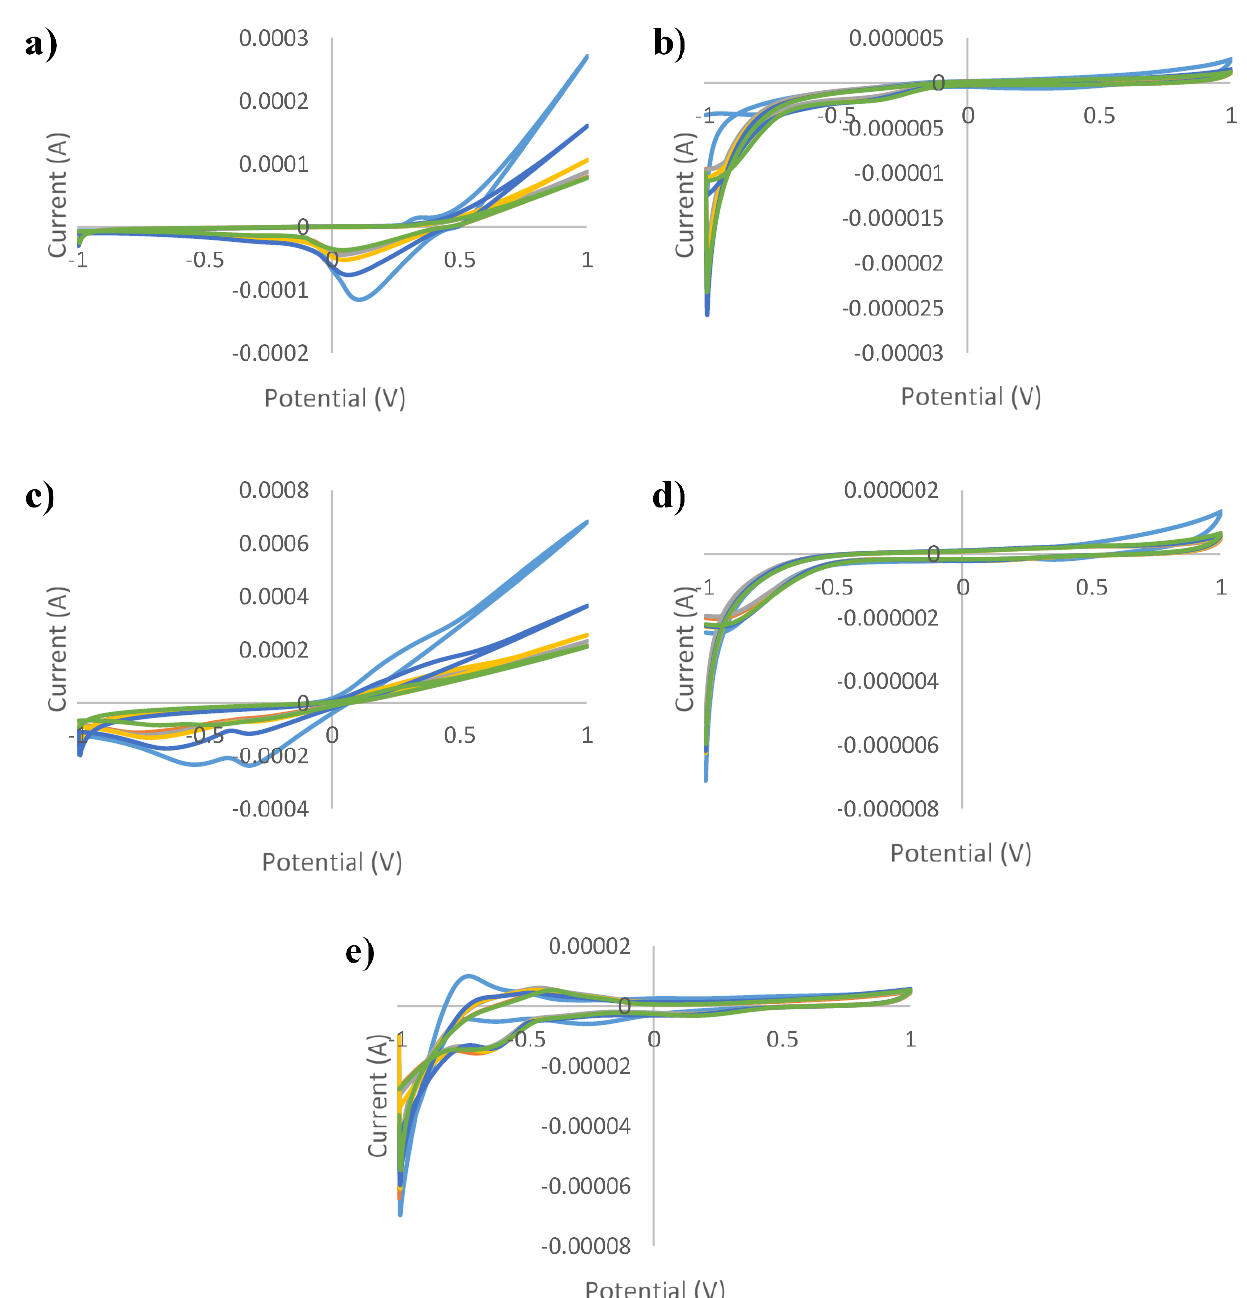
Figure 2. Cyclic voltammograms of authentic and adulterated (with maple syrup) tilia honey solutions for: ( a ) silver electrode; ( b ) gold electrode; ( c ) copper electrode; ( d ) glass electrode; ( e ) platinum electrode and green line—authentic honey; light blue line—agave syrup; red line—honey adulteration 5%; gray line—honey adulteration 10%; orange line—honey adulteration 20%; dark blue—honey adulteration 50%.